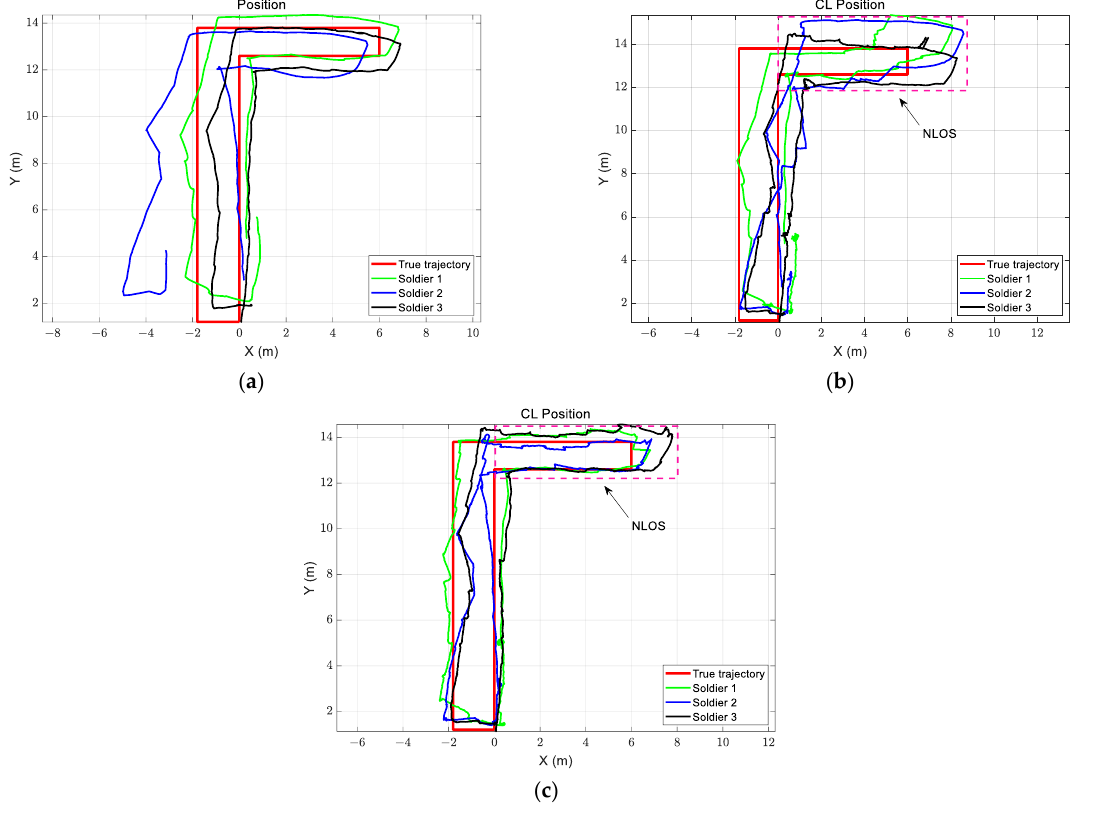
Figure 5. Trajectories with different algorithms. ( a ) Inertial navigation trajectories; ( b ) trajectories with CL algorithm (without dealing with NLOS errors); ( c ) trajectories with CL algorithm (dealing with NLOS errors).